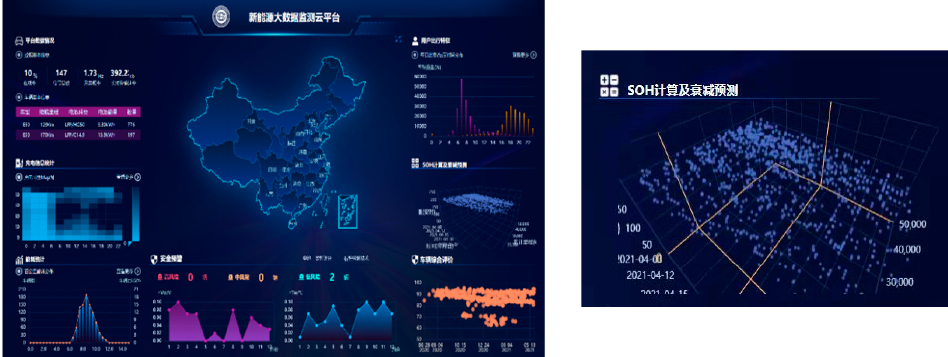
Figure 10. UI interface of big data monitoring cloud platform of Sichuan new energy innovation center.